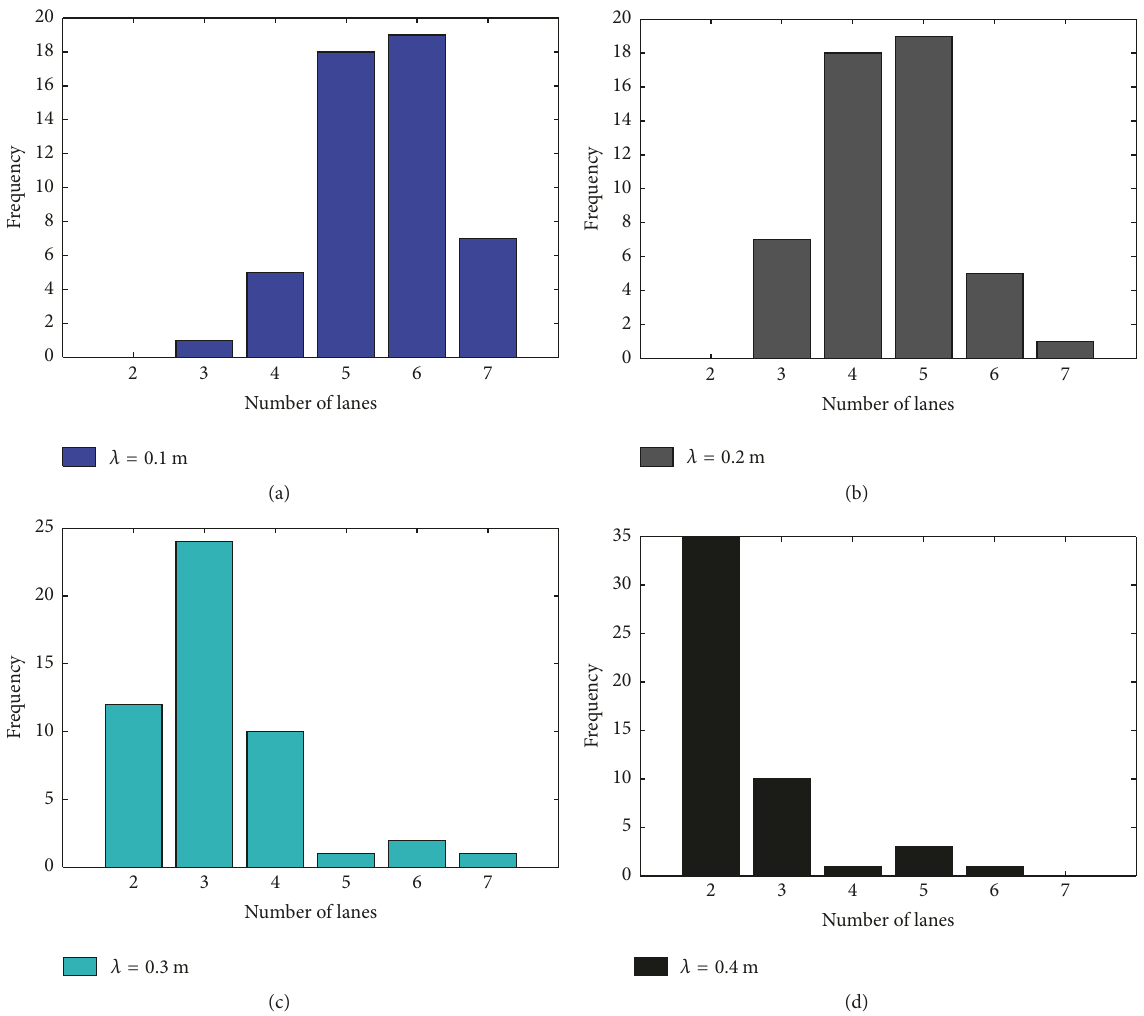
Figure 15: The frequency of number of lanes formed for different 𝜆 . For comparison with the actual data shown in Figure 14, in the simulation, the pedestrians are added into the area from the left boundary and the right boundary with the same pedestrian arrival rate (0.2 P/(m ⋅ s)), and this arrival rate leads to the same density as in Figure